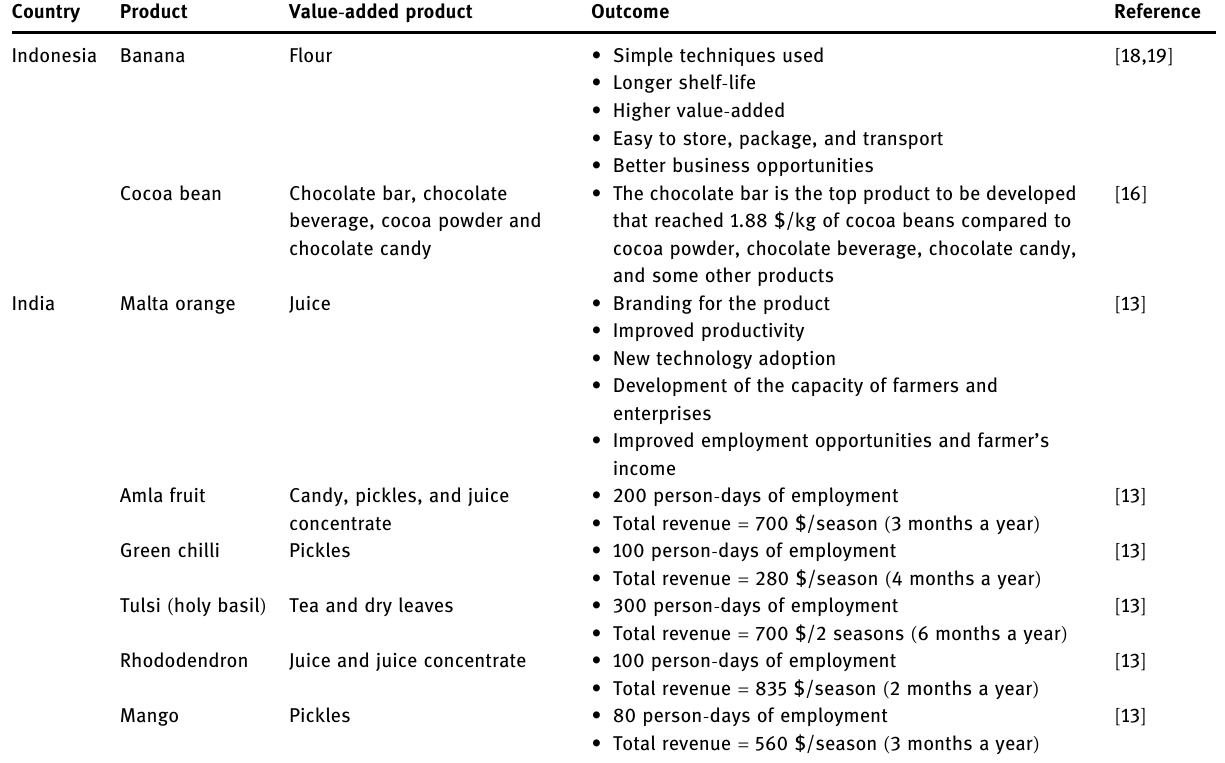
Table 1: Success stories of value addition Country